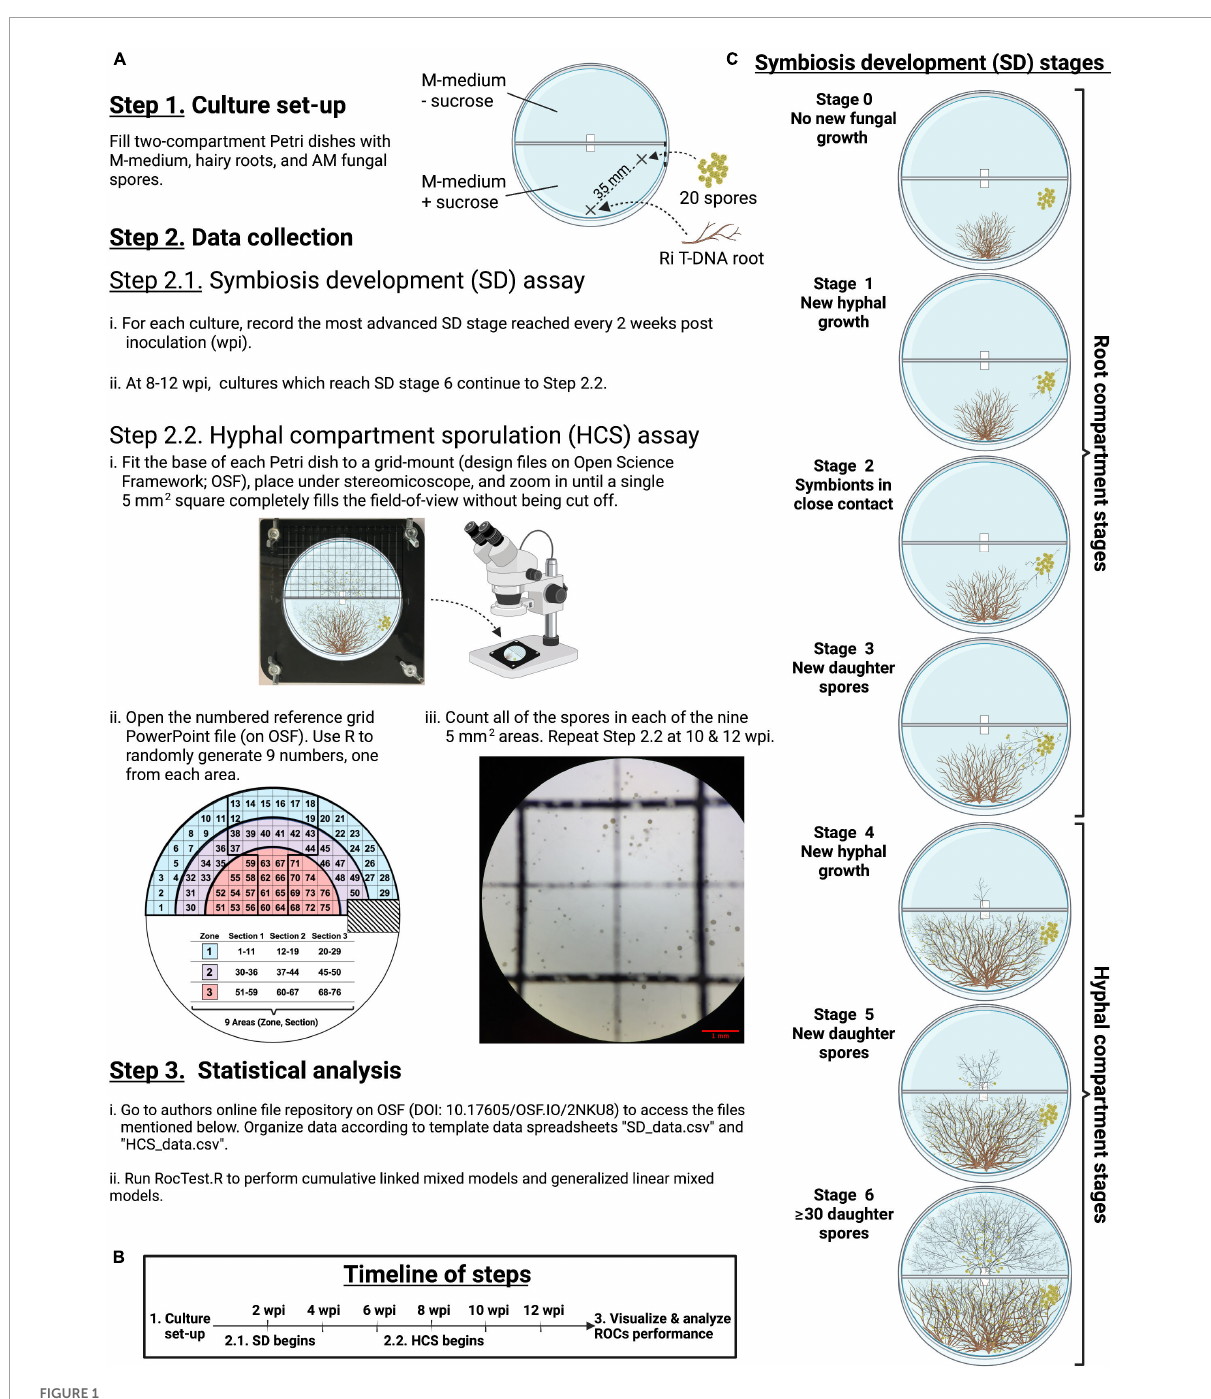
FIGURE1 Step-by-step flowchart of the experimental design (A) , the timeline (B) , and illustrations of each stage of the symbiosis development (C) .